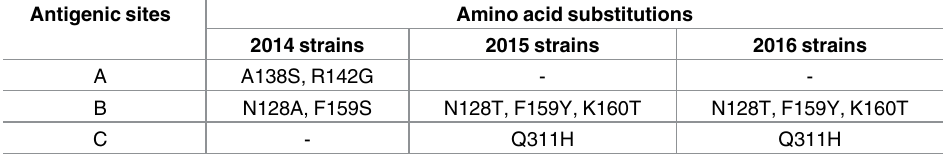
Table 1. Comparison of Cameroonian virus strains with respect to